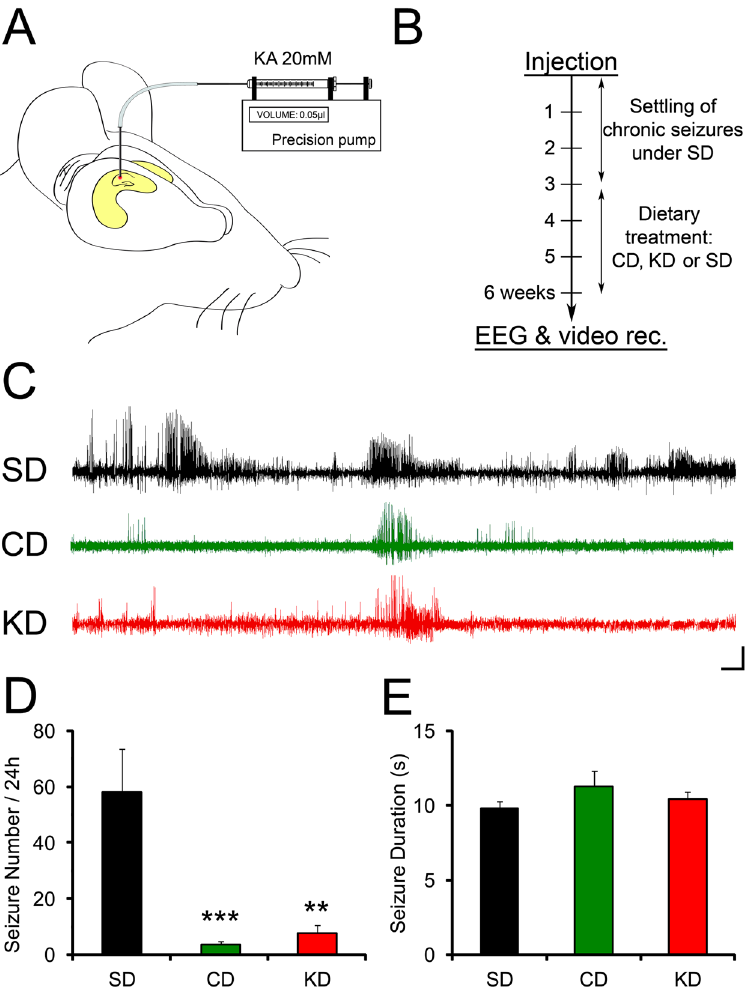
Figure 4. CD treatment reduces chronic seizure occurrence. ( A ) The KA mouse model of chronic epilepsy. KA (20 mM) was injected unilaterally by mean of a cannula connected to a precision pump into the intra- hippocampal region. ( B ) Mice under SD were left 3 weeks to develop chronic seizures and were then fed with KD or CD, controls were left on SD. ( C,D ) EEG detected seizures were drastically decreased in mice treated with KD (n = 8, p < 0.01) and CD (n = 13, p < 0.001) compared with SD controls (n = 10). ( C,E ) EEG detected seizures showed similar durations between SD, KD and CD mice. Calibration bars: 10 min, 200 µ V. ** p < 0.01, *** p <